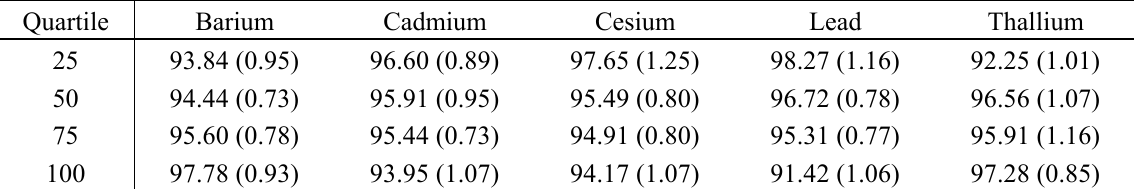
Table 14. Waist Circumference by Metal Quartiles for